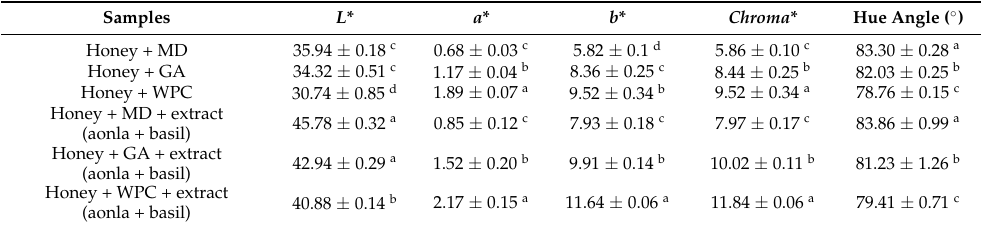
Table 4. Colour parameters L *, a *, b *, Chroma * and Hue angle of spray-dried nutritionally rich honey powders fortified with different carrier agents.